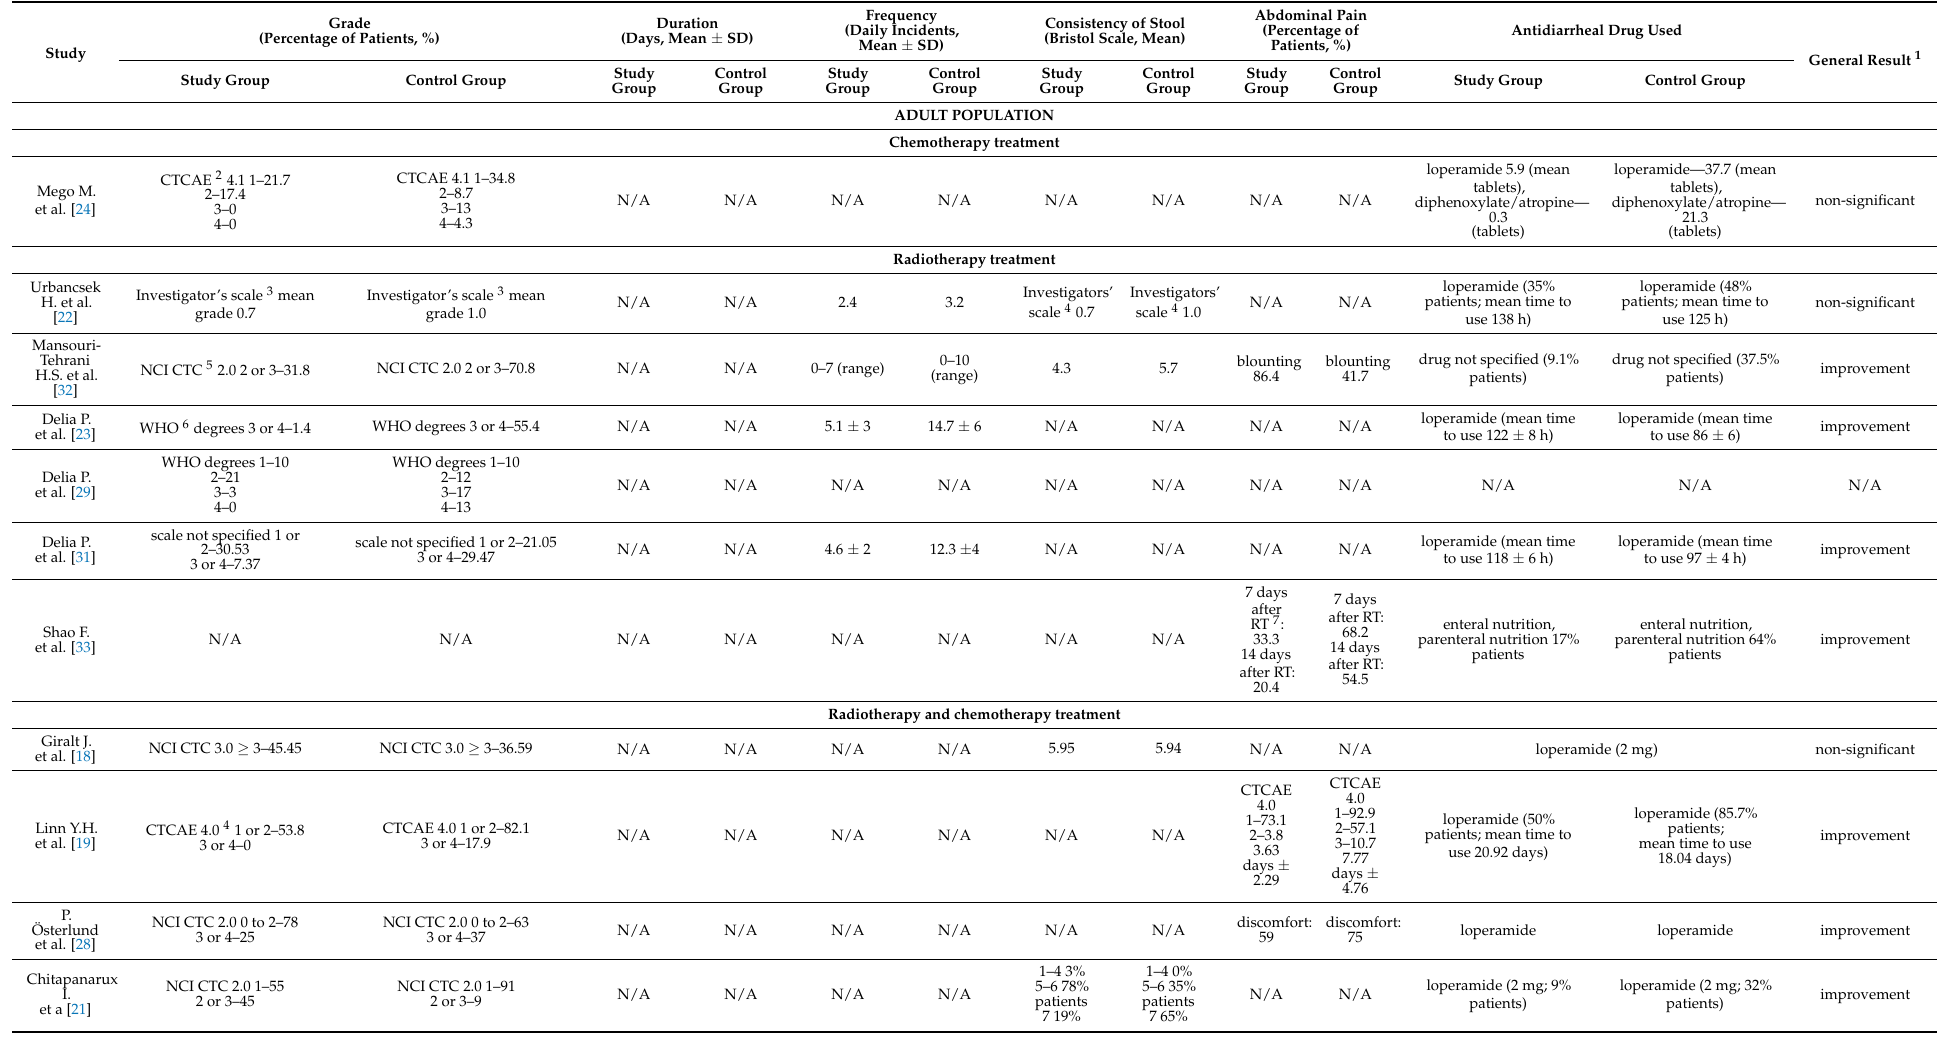
Table 3. The occurrence of diarrhoea during the probiotic